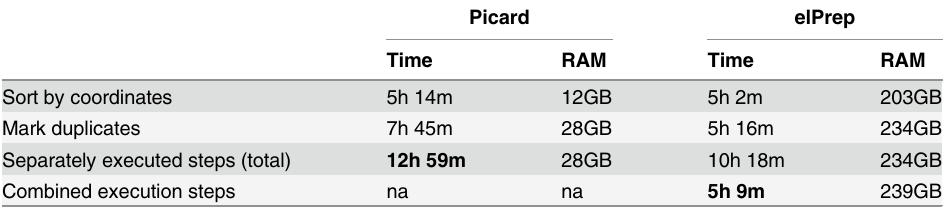
Table 4. Benchmarks of the 2-step pipeline on NA12878 whole genome (Basic protocol 1).